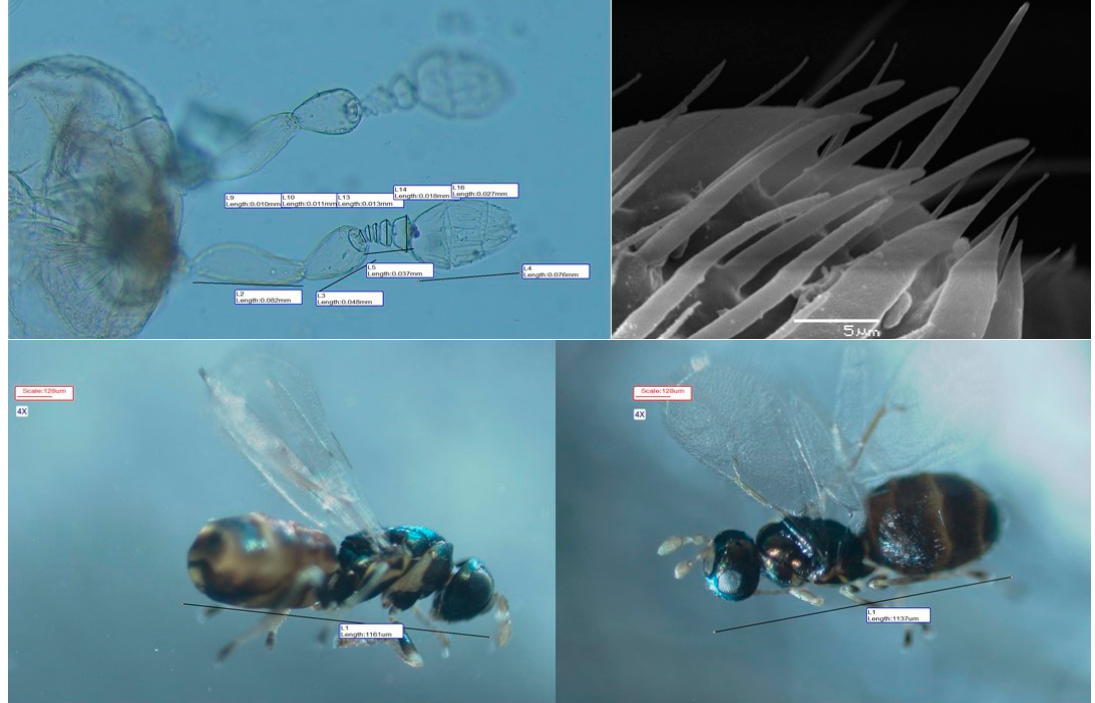
Figure 2. Ophelimus migdanorum nov sp . key morphological characteristics: ( a ) Antenna and ( b ) top Figure 2 Ophelimus migdanorum nov sp . key morphological characteristics: (a) Antenna and (b) top club. ( c ) Female, and ( d ) club. (c) Female, and (d) male.